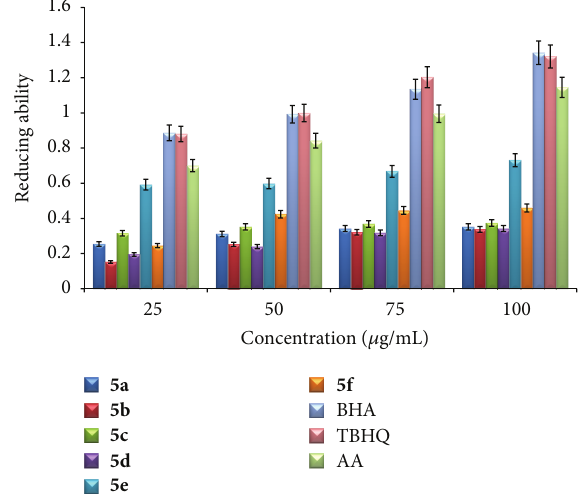
Figure 2: RSA of the compounds ( 5a–f ).